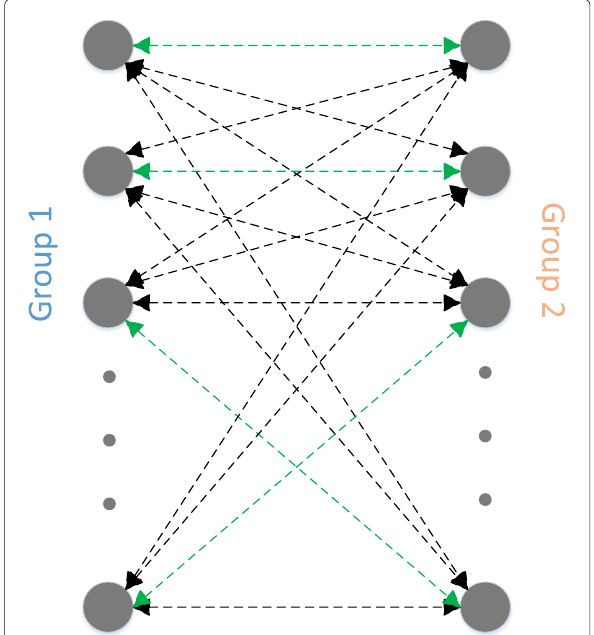
be used to search out an optimal matching result. The result tells us which two areas are most suitable to reuse the same sub resource pool.